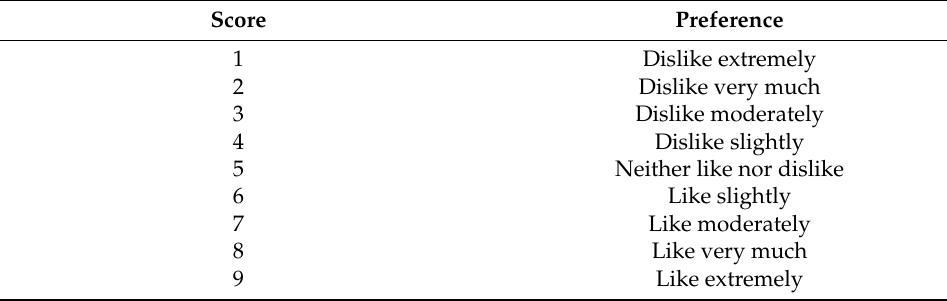
Table 2. The nine-level preferences in the hedonic test.